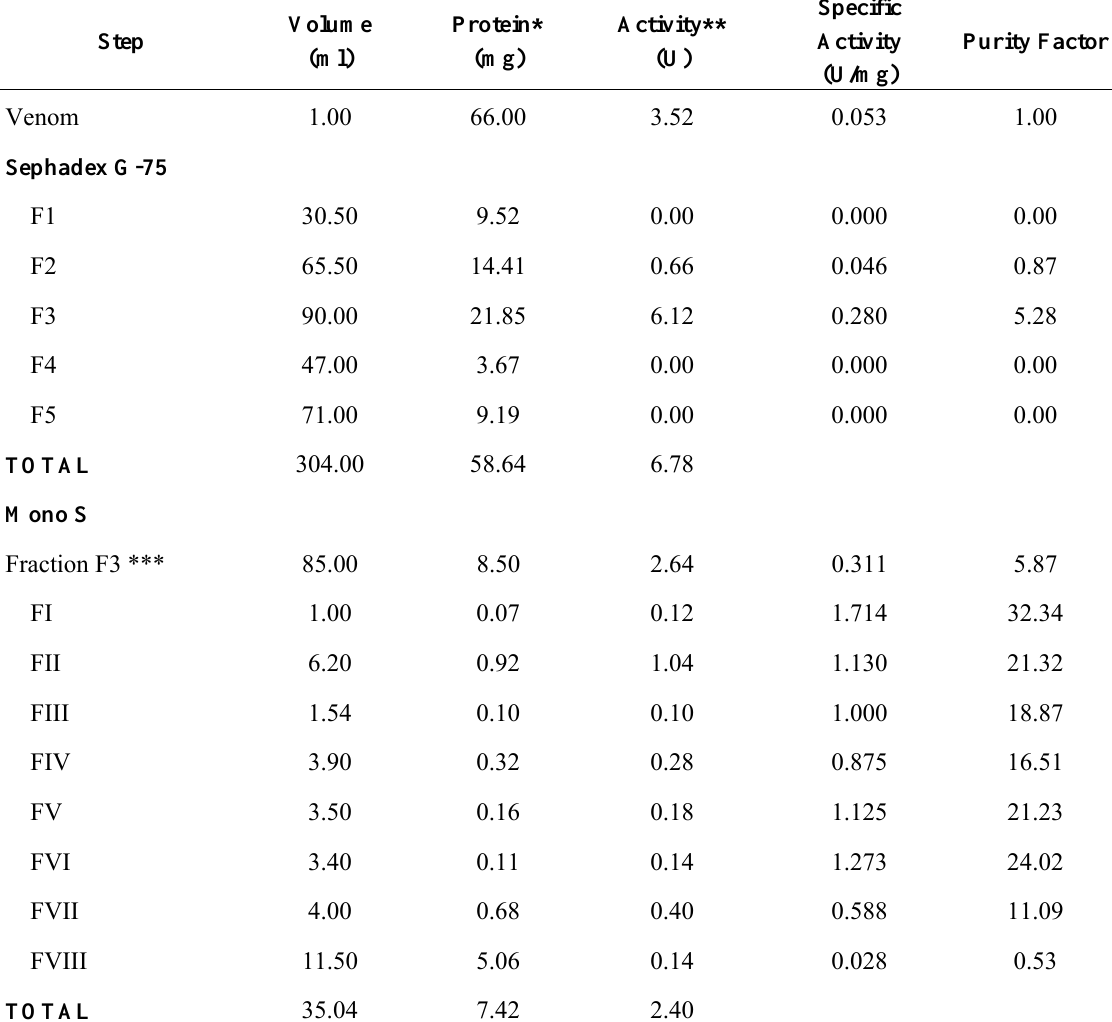
enzymes from B. asper 2